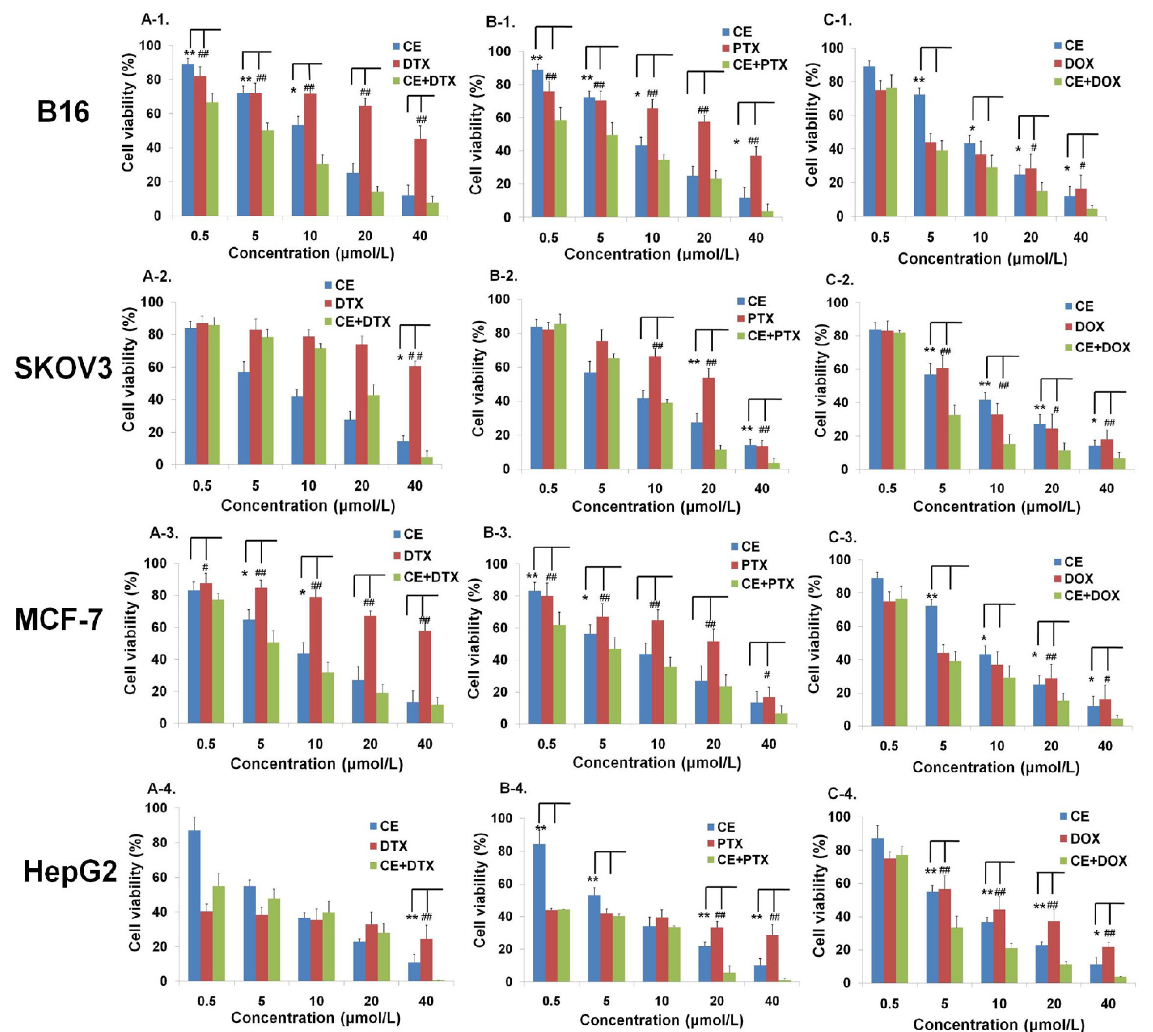
Figure 1. Effects of different treatments on cell viabilities (% from untreated control) of B16, SKOV3, MCF-7 and HepG2 cells ( n = 3). Cells were treated with CE, DTX, PTX, DOX, or 1:1 combination molar ratio of CE plus one of the three anti-tumor drugs, respectively, at a series of concentration from 0.5 to 40 μ M. ( A-1 – A-4 ) The comparative test among CE, DTX, and CE + DTX; ( B-1 – B-4 ) The comparative test among CE, PTX and CE + PTX; ( C-1 – C-4 ) The comparative test among CE, DOX and CE + DOX. * p < 0.05, ** p < 0.01, statistically significant difference between CE and combination treatment (CE + DTX, CE + PTX, or CE + DOX, respectively); # p < 0.05, ## p < 0.01, statistically significant difference between DTX and combination treatment (CE + DTX, CE + PTX, or CE + DOX,